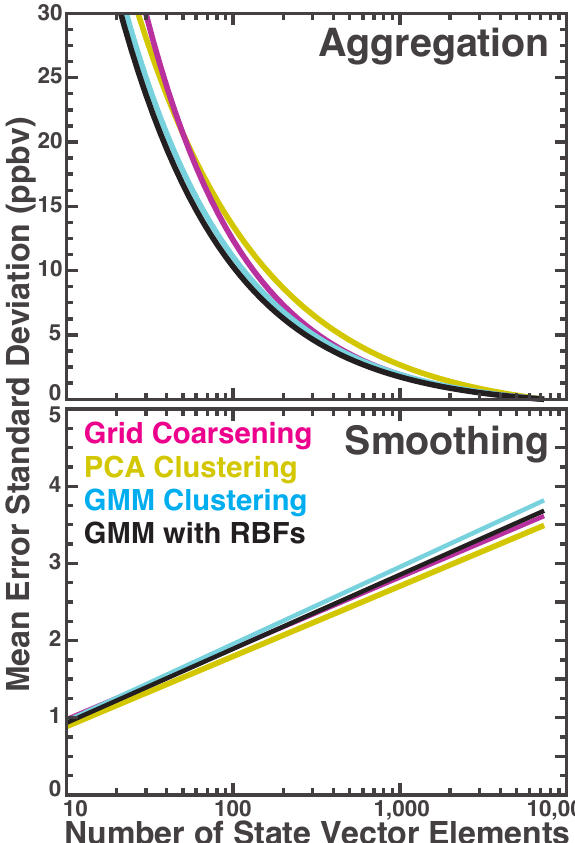
Figure 3. Aggregation and smoothing error dependences on the aggregation of state vector elements in an inverse model. The ap- plication here is to an inversion of methane emissions over North America using satellite methane data with 7366 native-resolution state vector elements (Sect. 5 and Turner et al., 2015). Results are shown as the square roots of the means of the diagonal terms (mean error standard deviation) in the aggregation and smoothing error co- variance matrices. Different methods for aggregating the state vec- tor (Sect. 4) are shown as separate lines. Note the log scale on the x